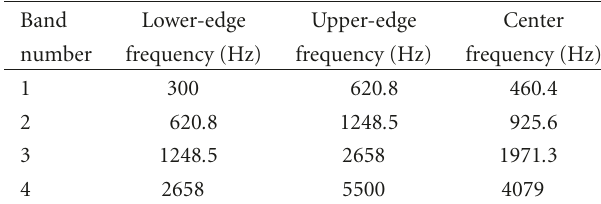
Table 3: The frequency bands in which the HNR values are esti-